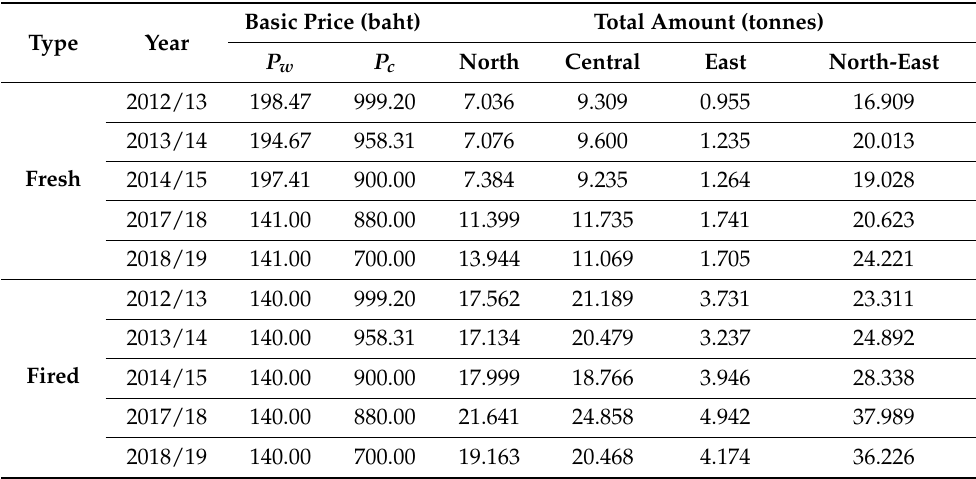
Table 1. The basic prices (Baht/tonne) set by the Royal Thai Government and the total amounts (10 6 tonnes) of fresh and fired sugarcane delivered to the factories in each region in each crop year.